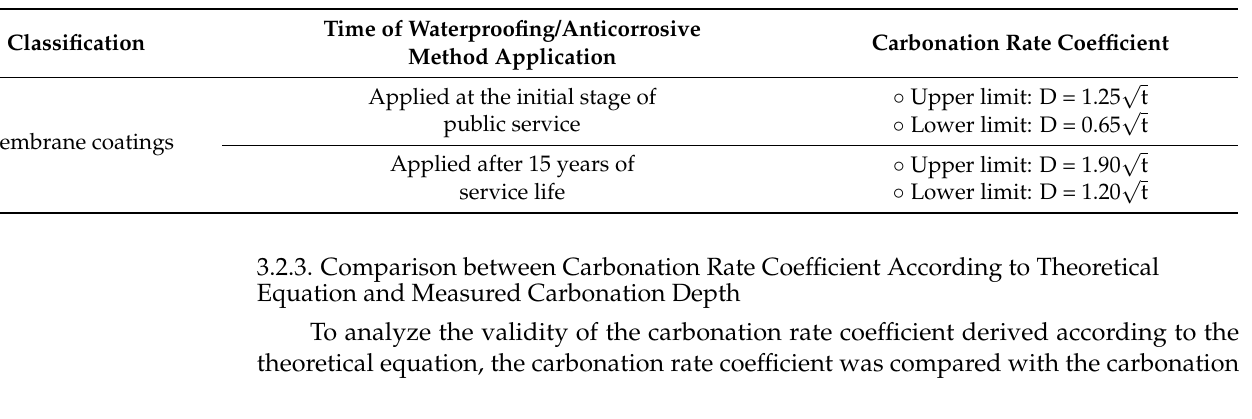
Table 6. Results of carbonation rate coefficients of concrete inner walls in the water